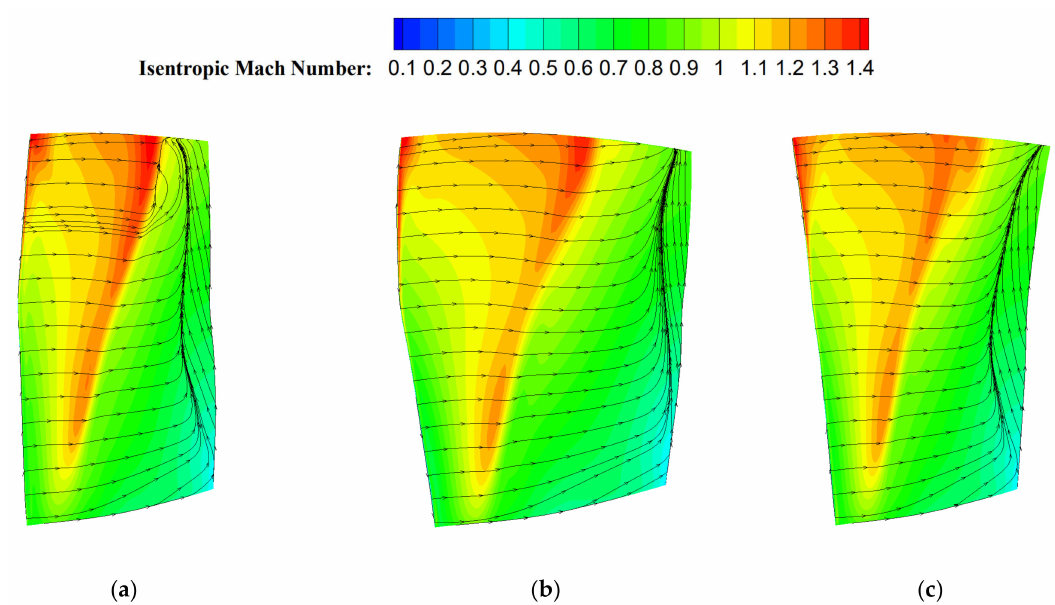
Figure 13. Contours of the isentropic Mach number and limiting streamlines on the rotor suction surface: ( a ) ORI; ( b ) OPT1; ( c )